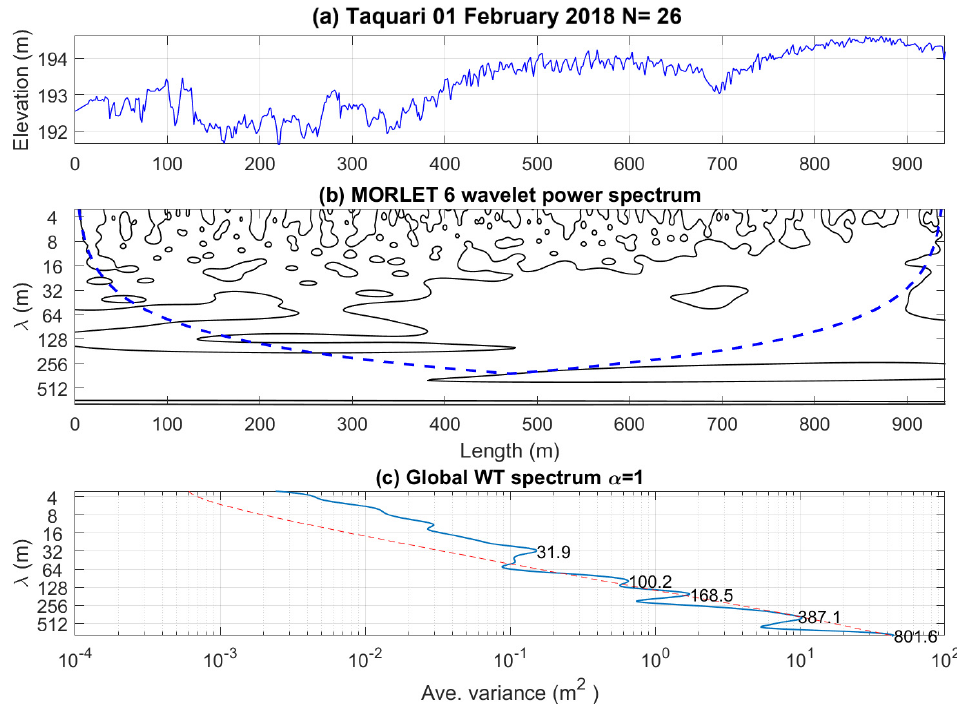
Figure 14. Wavelet analysis for profile N = 26 on 1 February 2018. Flow occurs from left to right. ( a ) Longitudinal bed elevation; ( b ) spatial distribution of wavelengths ( λ ), through wavelet power spectrum contours using the Morlet function; ( c ) global wavelet power spectrum, indicating the main wavelength frequencies.